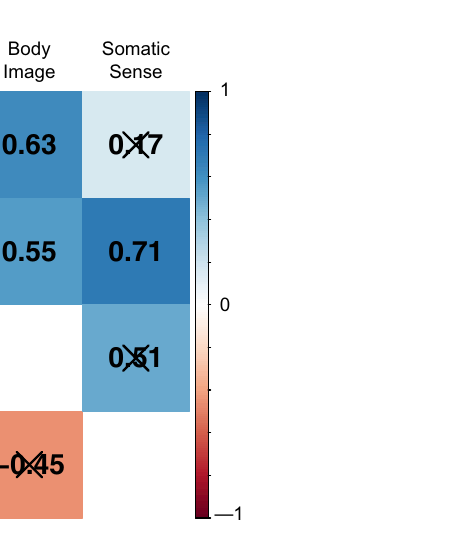
Figure 3. Subjective ratings for disruption of body-related awareness. Higher values indicates higher disruption scores for each item without reverse scoring because all the questions asked for the degree of disruption. Each data point represents a participant’s score. An asterisk indicates the statistical significance (* p < 0.05). Box-and- whisker plots represent the median of the data (thick lines), data between the first and third quartiles (boxes), and the maximum and minimum data (whiskers). There are no outliers.